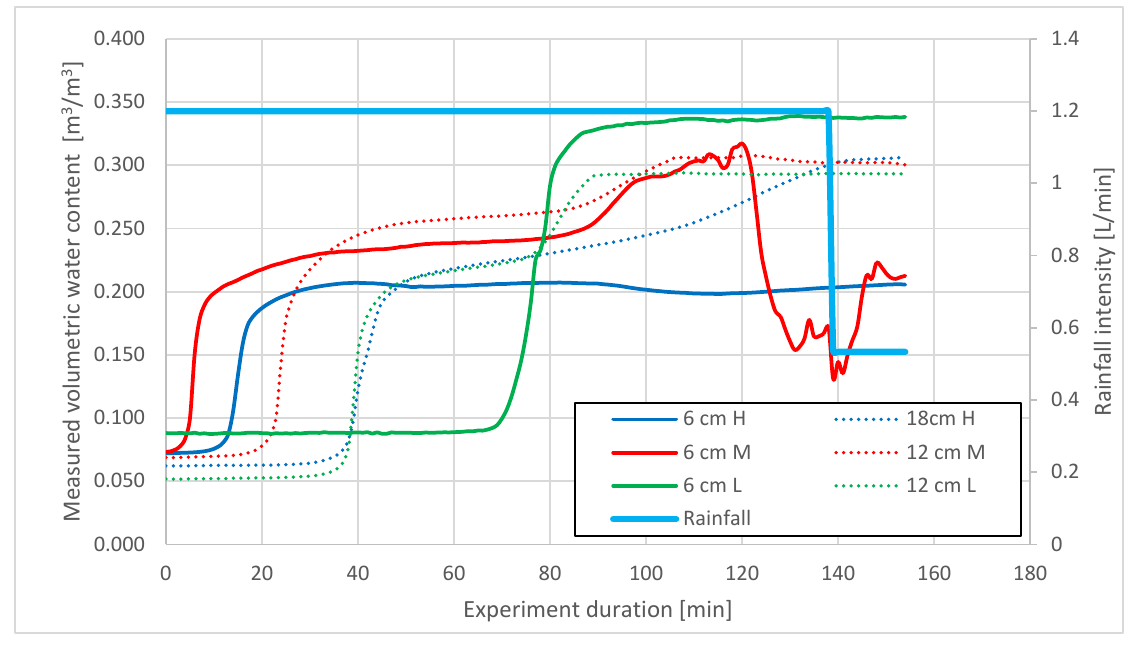
Figure 5. Measured volumetric water content during the SK10 experiment. Measured locations (H, M and L) are shown in Figure 2.